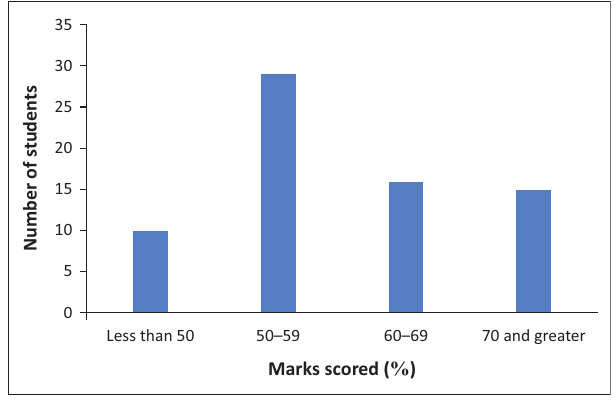
FIGURE 2: Percentage performance of teacher students on nominal and effective rate